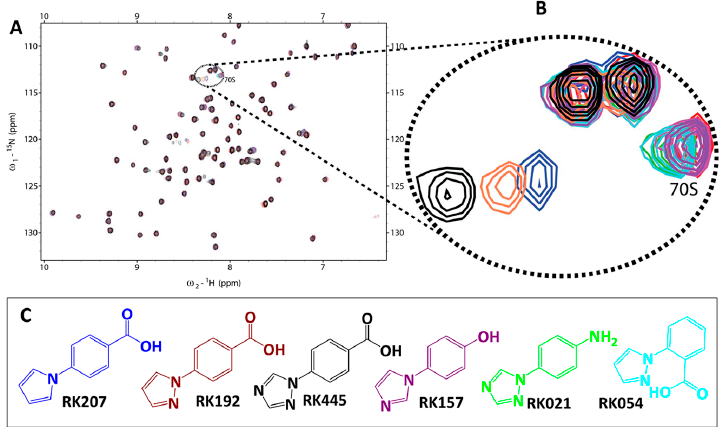
Figure 7. ( A ) 15 N-HSQC comparison of binding modes among different functional groups as well as their orientation. 2 mM of RK207 and each of its analog fragments are observed against 0.25 mM 15 N BrmGRX; ( B ) Enlarged S70 peaks; and ( C ) RK207 and its’ analogs. (Red: apo, blue: RK207, brown